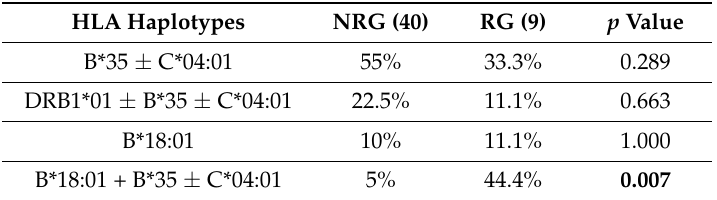
Table 1. Distribution of the analyzed haplotypes in the non-recurrence (NRG) and recurrence (RG) groups.